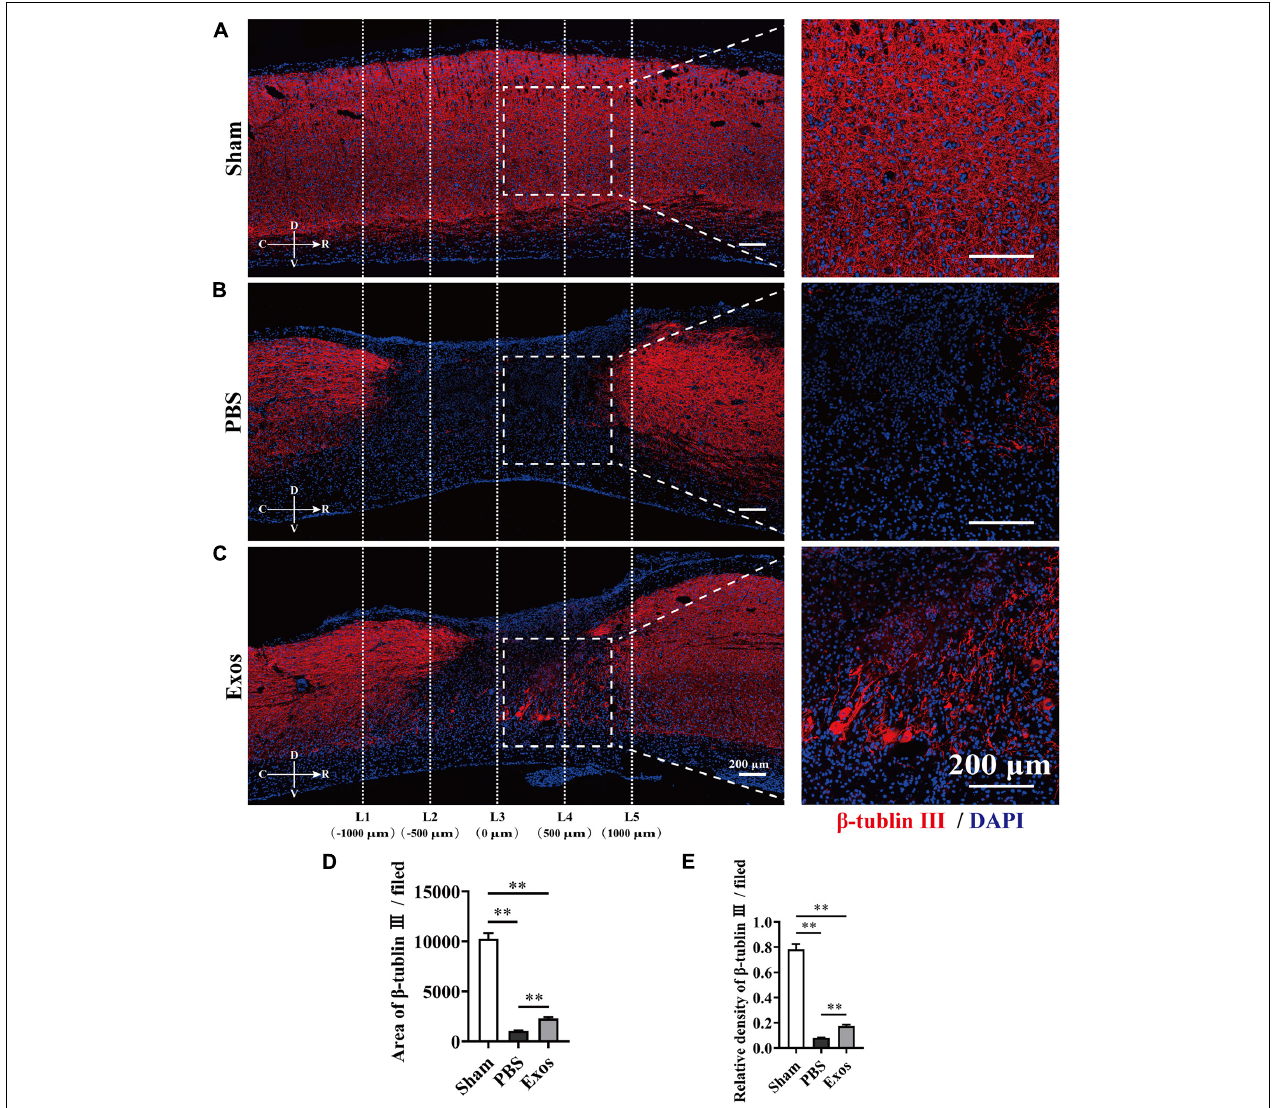
FIGURE 4 | Bone marrow mesenchymal stem cell-derived exosomes (BMSC-Exos) improved axon growth after spinal cord injury in vivo . (A–C) Representative immunofluorescence images of the axon marker β -tubulin III (red) in the sham, phosphate-buffered saline (PBS), and Exos groups. Nuclei were counterstained with DAPI (blue). The white dashed line outlines the distance rostrally or caudally from the injured epicenter of the injured spinal cord. White dashed rectangular frames of region of interest (ROI) are selected for quantitative analysis of the axon area and density among different treatment groups. Scale bars = 200 µ m. (D,E) Immunofluorescence semiquantification of the area and relative density of β -tubulin III (red) within the ROI in the spinal cord at 56 days post-spinal cord injury (post-SCI) ( n = 5 per group, values are the mean ± SD, ∗∗ p < 0.01, one-way ANOVA). ROI, region of interest.